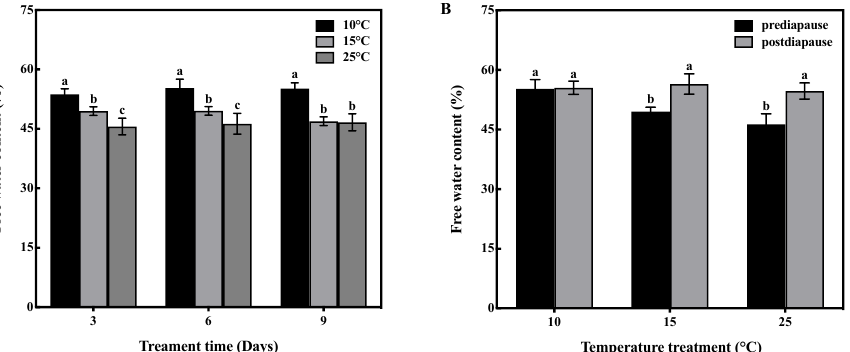
Figure 1. Effect of temperature acclimation on the free water content of queens. The value represents the percentage of the queen’s body weight for each sample. ( A ) Effect of temperature acclimation on the free water content of queens during prediapause. Different letters represent statistical significance between the different temperatures ( p < 0.05). ( B ) Effect of temperature acclimation for 6 days during prediapause on changes in the free water content of queens during diapause. Different letters represent statistical significance between the different periods of diapause ( p <